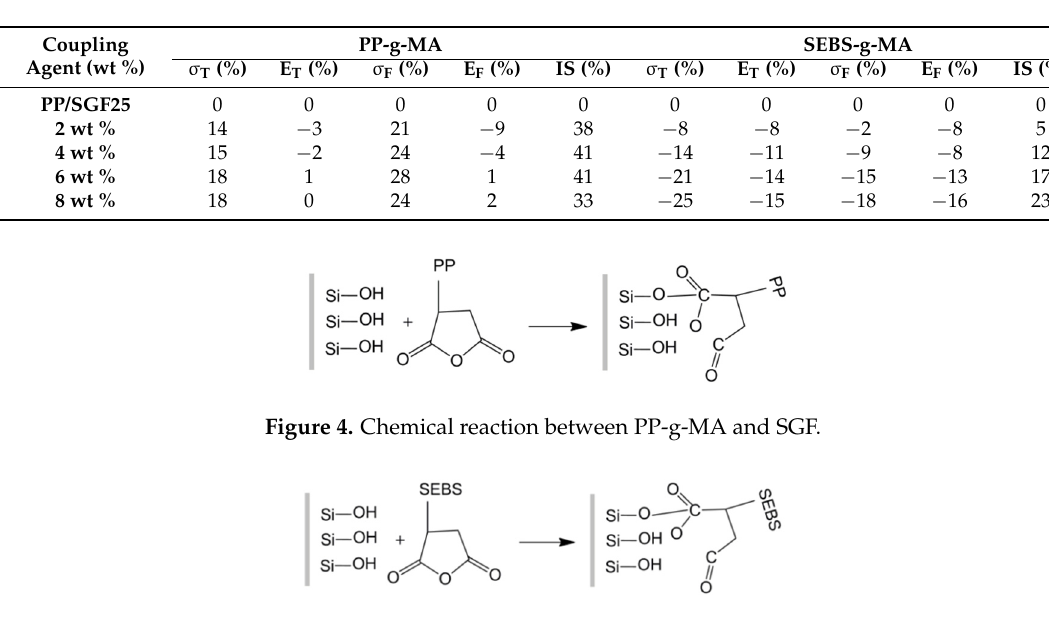
Table 3. Variations in tensile, flexural, and impact properties in percentage (%).